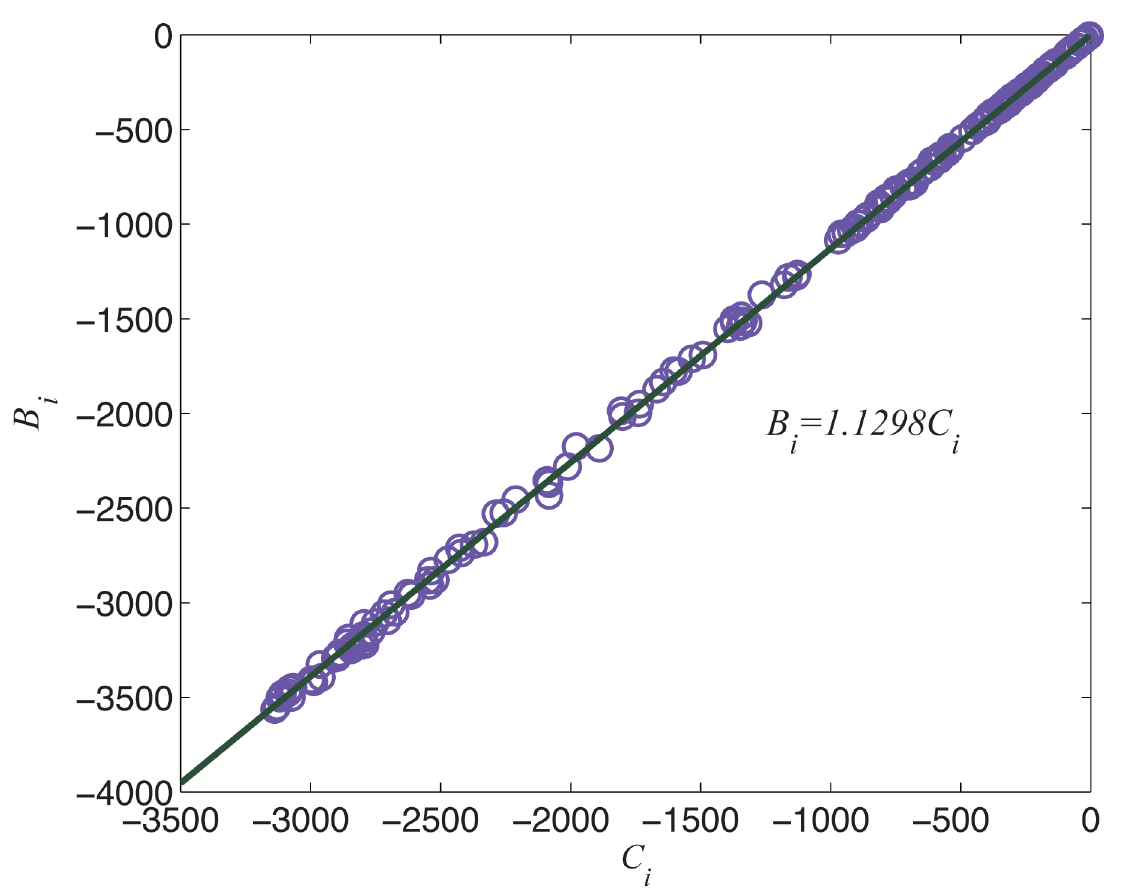
Fig 9. The linear relationship between C i and B i